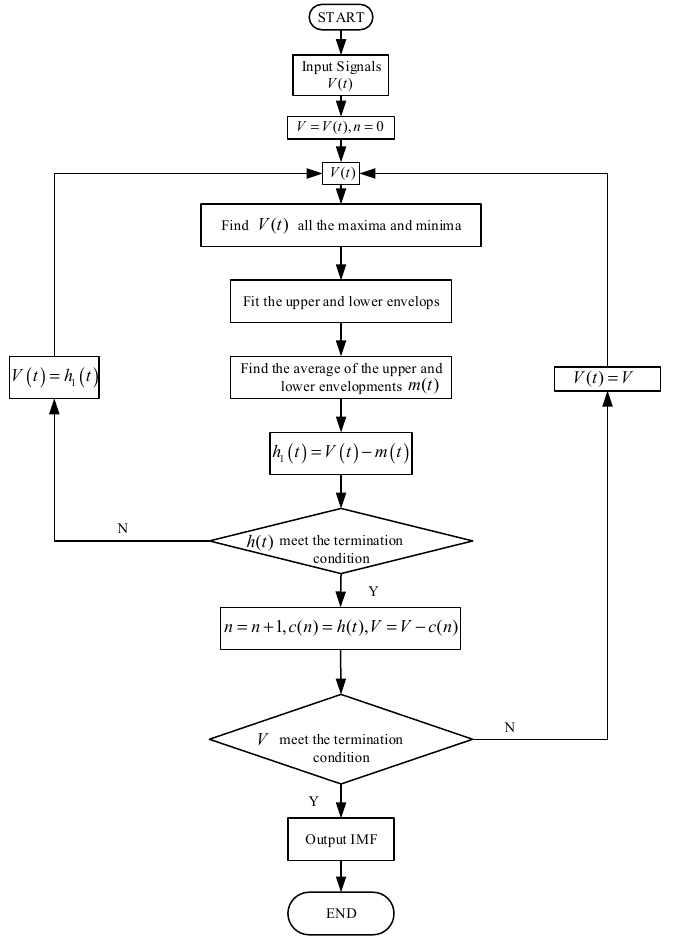
Figure 1. Flowchart of the empirical mode decomposition (EMD) algorithm.